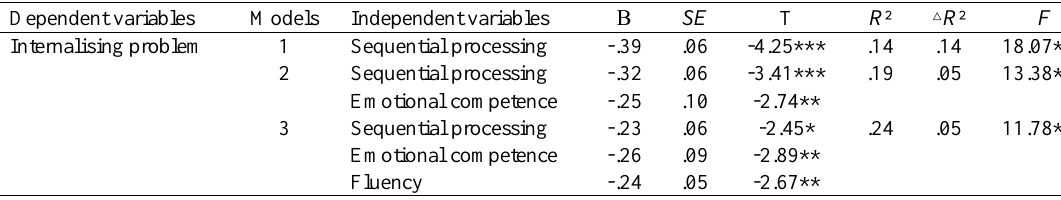
Note: * p < .05, ** p < .01. Table 2 Predictors of internalising problems ( N = 203)